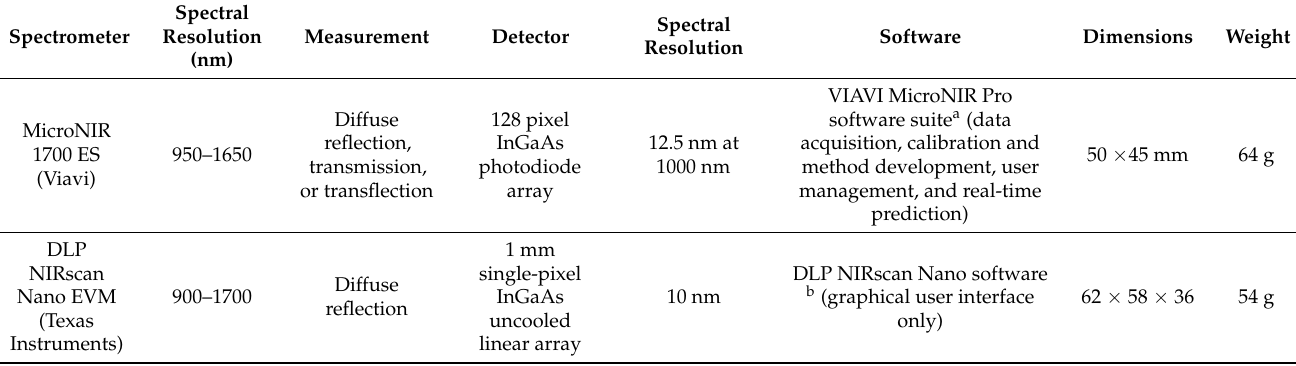
Table 1. Overview of a selection of commercially available handheld